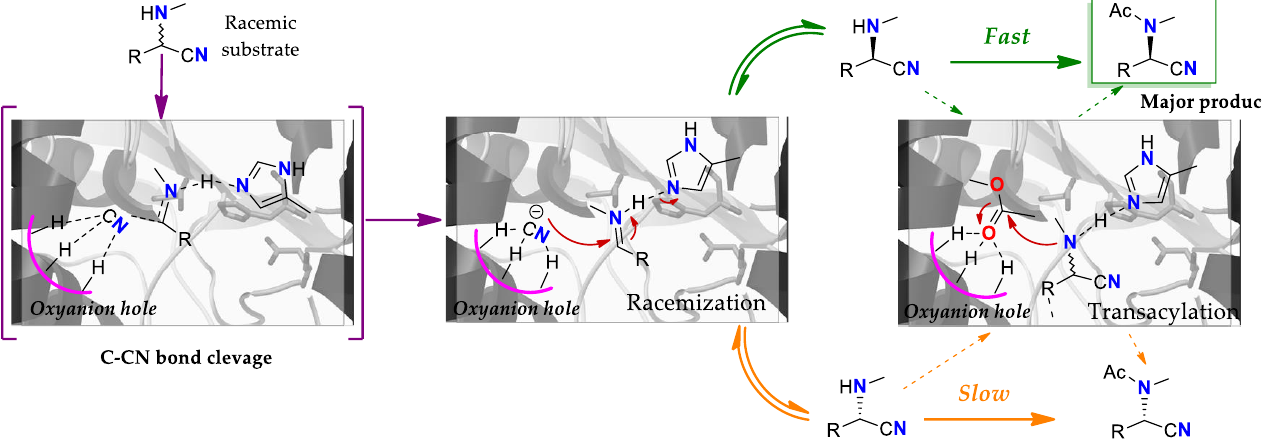
Figure 10. BCL as a dual biocatalyst. Acting as racemase of α -aminonitriles, facilitating the breaking and formation of the Cα -CN bond, in this way the two possible enantiomers are synthesized. In addition, the same BCL, acting as a transacylase, favors one of the two enantiomers, reaching an e.e of 85% adapted from [32].